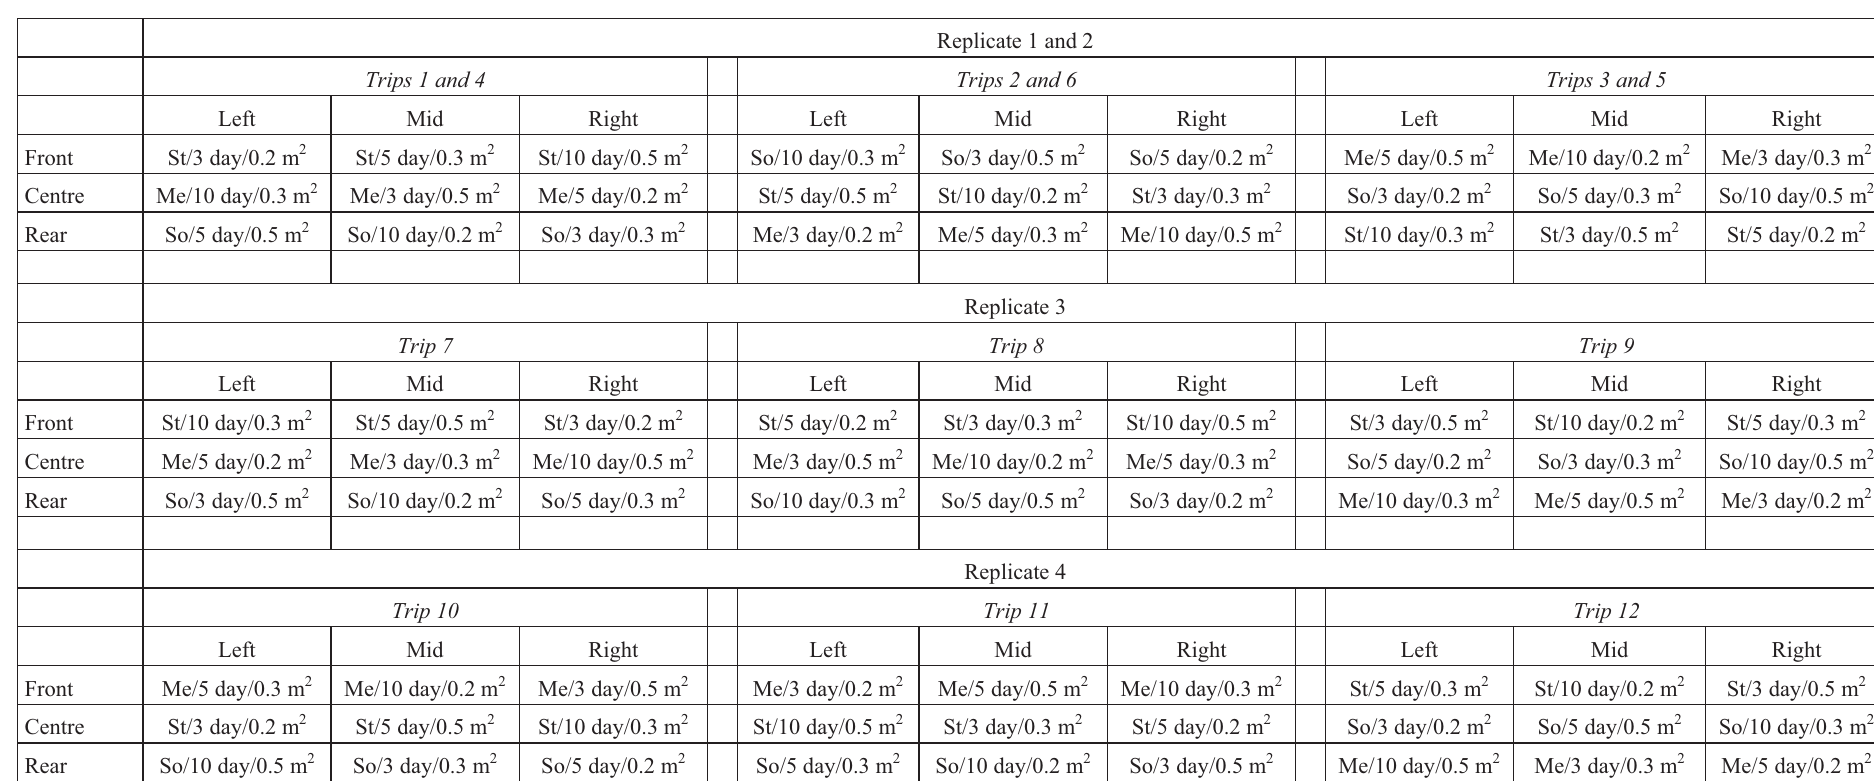
Table 1. Diagrammatic representation of the allocation of treatments to trips, and to the truck position for each trip. St denotes straw flooring, So denotes solid flooring and Me denotes mesh flooring. Number of days is the age of calf and the area is the space per calf in a pen of four